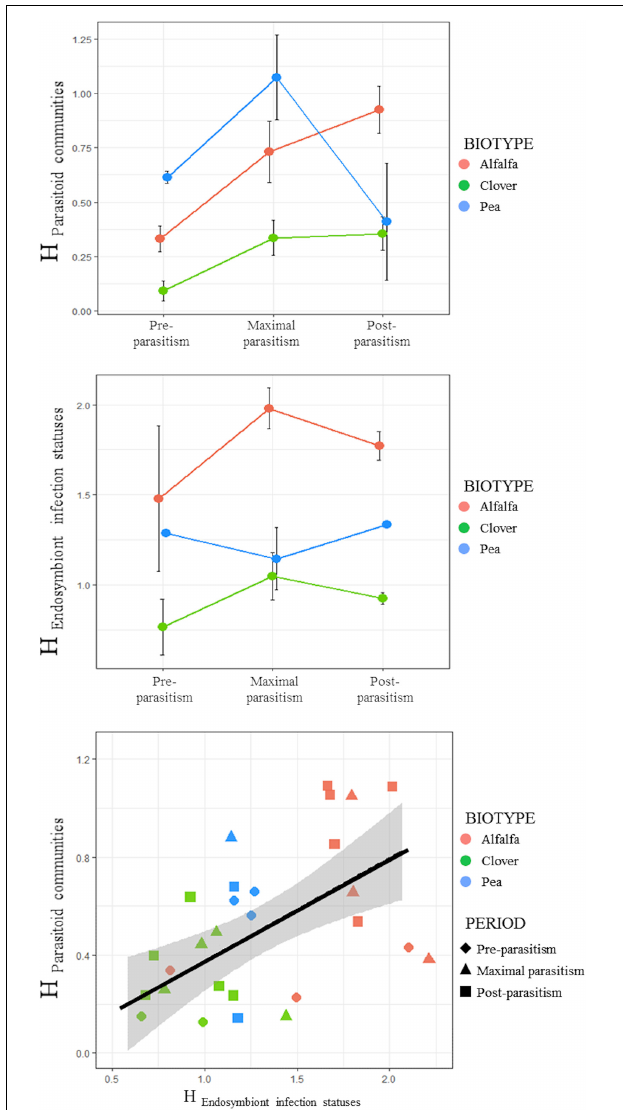
FIGURE 3 | Shannon Index (H) of parasitoid communities and endosymbiont infection statuses, and covariation between both Shannon Indices, considering both the pea aphid biotypes and the parasitism